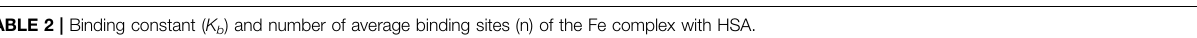
TABLE 2 | Binding constant ( K b ) and number of average binding sites (n) of the Fe complex with HSA. T